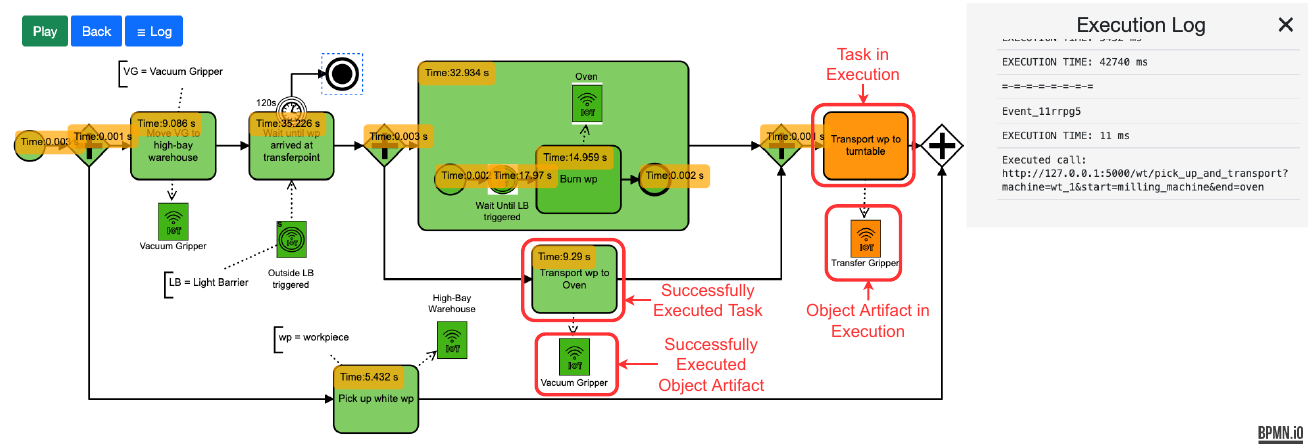
Figure 16. IoT-driven smart factory process in execution.